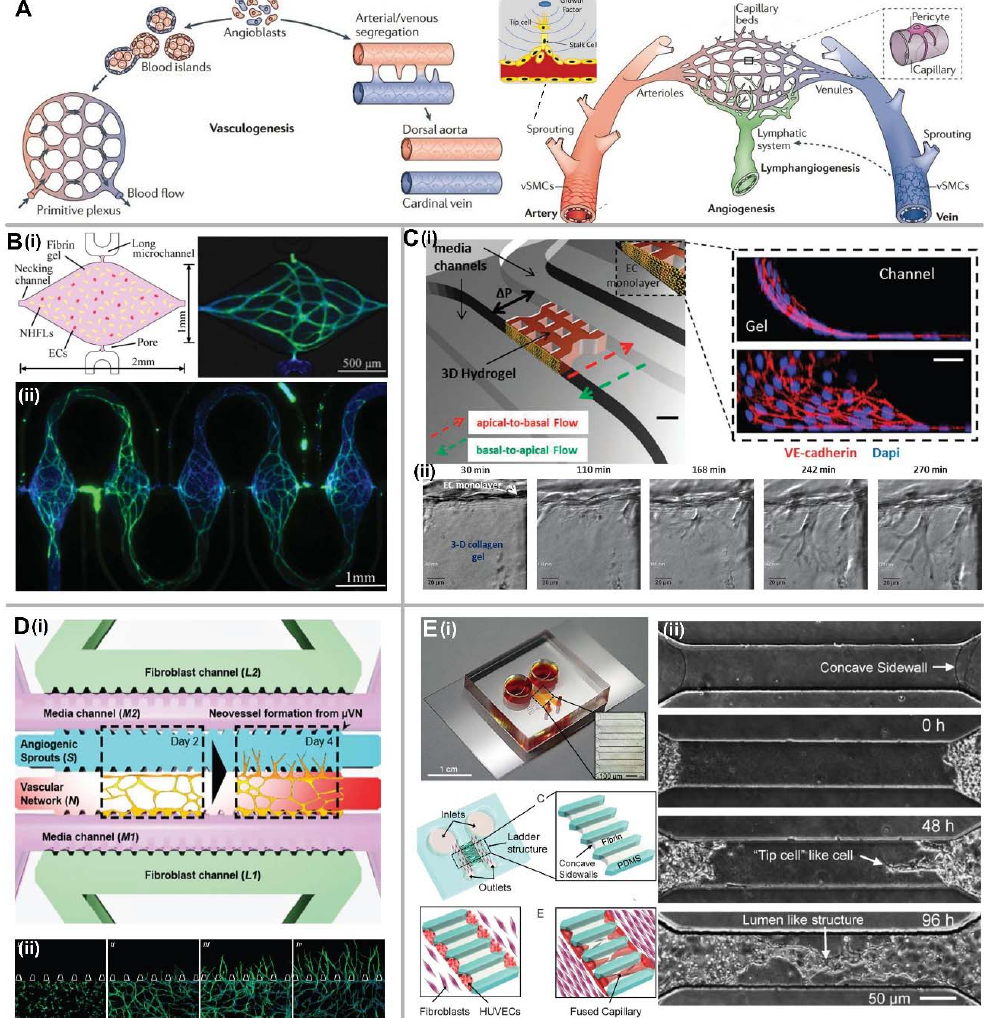
Figure 2. Vasculogenesis and angiogenesis-based methods for in vitro vascularization. ( A ) Schematic of vasculogenesis and angiogenesis in vivo. Adapted by permission from Reference [36], copyright Nature Publishing Group 2011. ( B ) 3D microvascuar network formation by vasculogenesis. ( i ) Schematic of 3D microtissue chamber seeded with ECs and NHLFs in fibrin gel, and formed microvascular network labeled with CD31 (green) and 4 ′ ,6-diamidino-2-phenylindole (DAPI) (blue) for nuclei. ( ii ) Fluorescent image of 5 interconnected microvascular networks. Adapted by permission from Reference [39], copyright Royal Society of Chemistry 2013. ( C ) Angiogenesis from EC monolayer. ( i ) Schematic of microfluidic-based 3D cell culture system, and the confocal images of confluent EC monolayer showing coverage on gel and channel surfaces immunostained with anti-VE-cadherin (red) and nuclei (blue). Scale bar, 500 μ m. ( ii ) Time-lapse images of sprouting angiogenesis induced by transendothelial flow. Scale bar, 20 μ m. Adapted by permission from Reference [48], copyright Royal Society of Chemistry 2012. ( D ) Angiogenesis from 3D microvascular network. ( i ) Configuration of the microfluidic device and schematic of the angiogenesis assay from microvascular network. ( ii ) Temporal sequence of interconnected vascular network formation and angiogenic sprouting from the formed network inside the adjacent microchannel. Scale bar, 100 μ m. Adapted by permission from Reference [51], copyright Royal Society of Chemistry 2016. ( E ) Anastomosis of sprouts into interconnected and perfusable blood vessels. ( i ) Schematic of microfluidic device design and self-organized capillary networks formed by HUVECs attached on the concave sidewalls from both sides. ( ii ) Images of sprouting HUVECs from both sides and fused capillary formation over time. Adapted by permission from Reference [52], copyright Royal Society of Chemistry